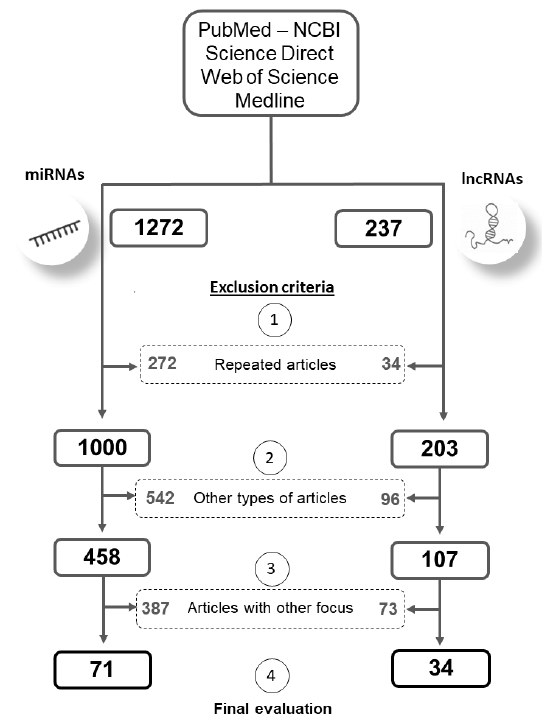
Figure 3. Schematic representation of study selection divided by microRNAs and long non-coding RNAs in four databases (PubMed, ScienceDirect, Medline, and Web of Science). Keyword variants were used to perform the search (long non-coding RNA; lncRNA; microRNA; miRNA; miR) AND